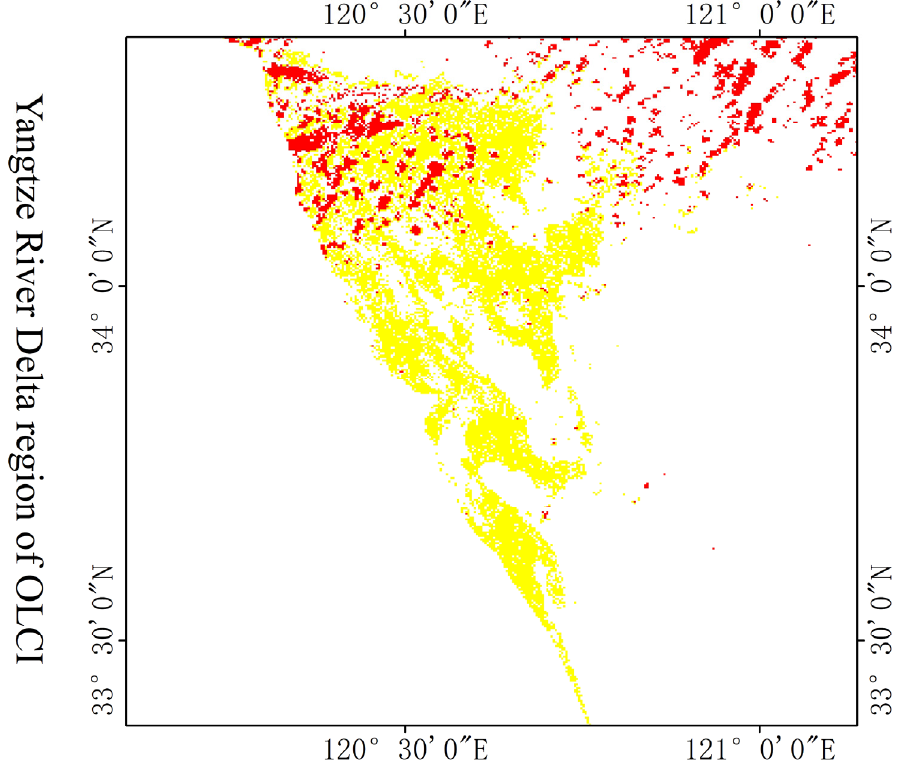
Figure 16. Schematic diagram of the missing OLCI data in the Yangtze River Delta region (Red for clouds, yellow for turbid water).